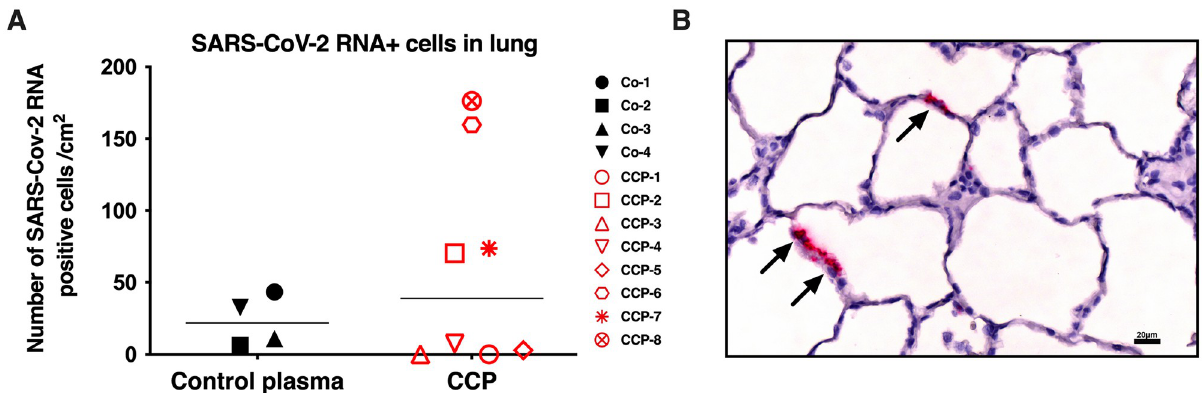
Fig 6. Quantitation of SARS-CoV-2 RNA-positive cells in lung sections. In situ hybridization (RNAScope) was used to detect viral RNA in lung sections. (A) For each animal, the number of positive cells was counted in approximately 20 fields of right caudal lung lobe. Lines indicate median values. There were no differences between both study groups (p = 0.89, Mann Whitney test). (B) Example of lung section of animal CCP-2, with the arrows indicating RNA-positive